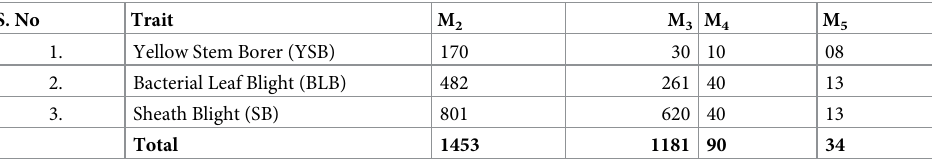
Table 2. Number of mutants exhibiting resistance to biotic stresses (YSB, BLB and Sheath Blight) from M 2 to M 5 generations. S.